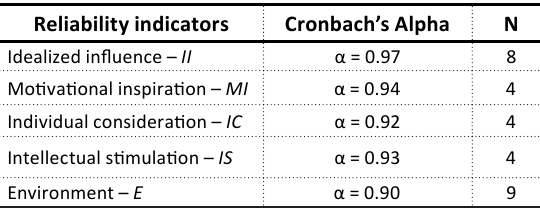
Table 3. Reliability of questionnaire